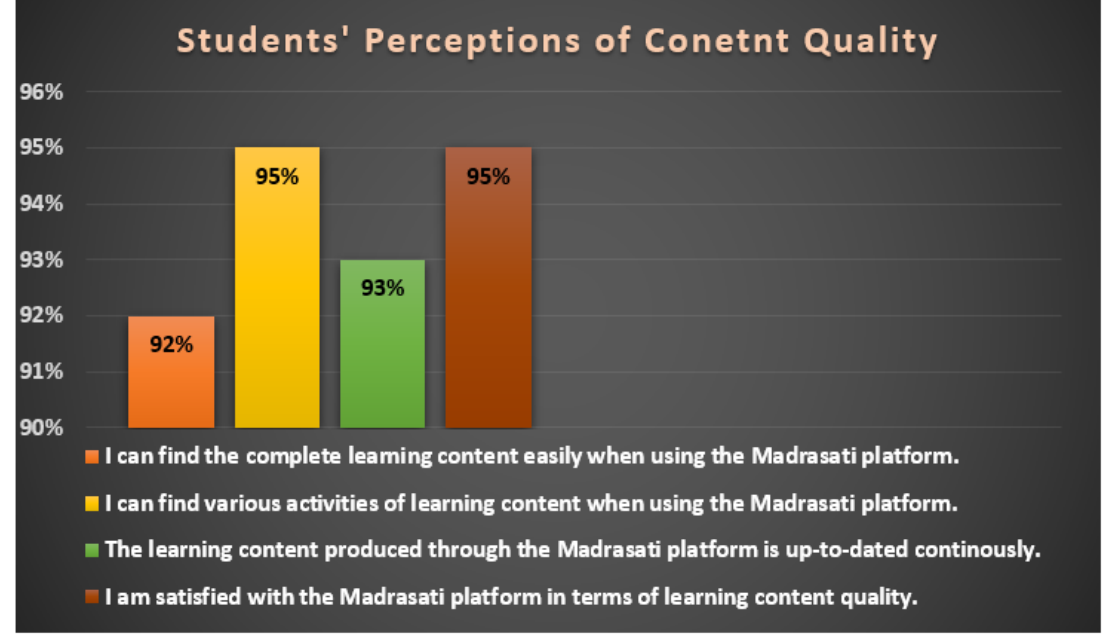
Figure 2. Students’ perceptions of CQ of the Madrasati platform.